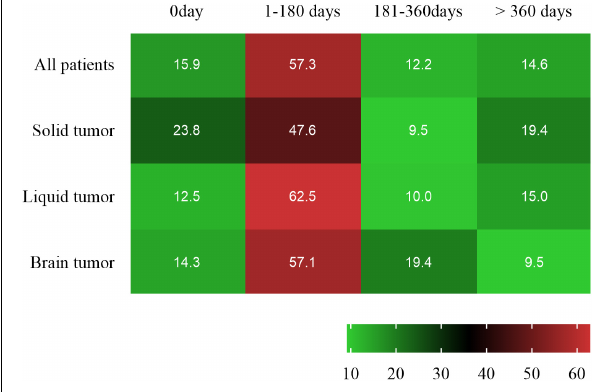
TABLE 1 | Demographics of cancer patients with subarachnoid hemorrhage a .